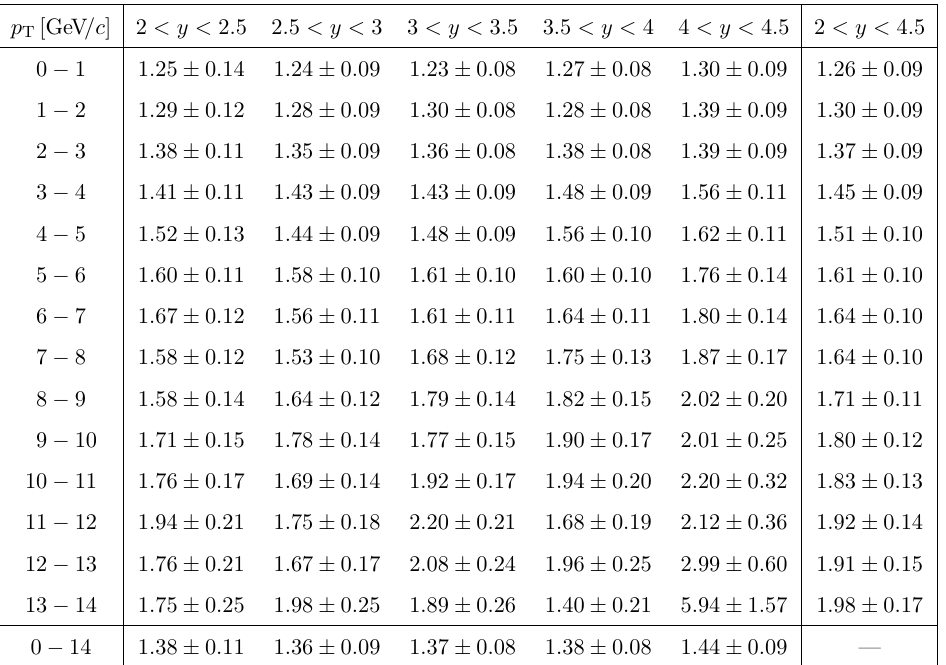
Table 9 . The ratio of cross-sections between measurements at 13 TeV and 8 TeV in di(cid:11)erent bins of p T and y for prompt J= mesons. The systematic errors are negligible.